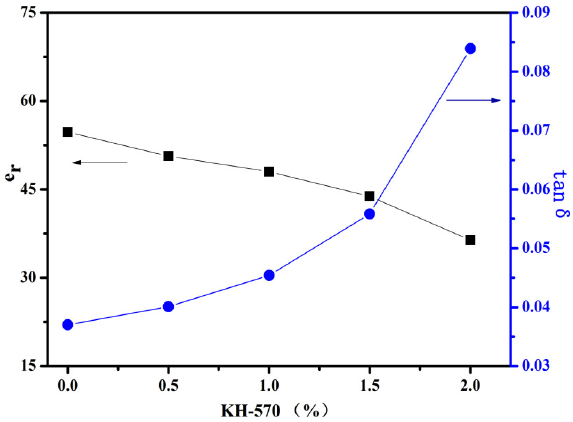
Figure 3. Effects of KH ‐ 570 on the dielectric properties of the PZT ‐ PVDF.